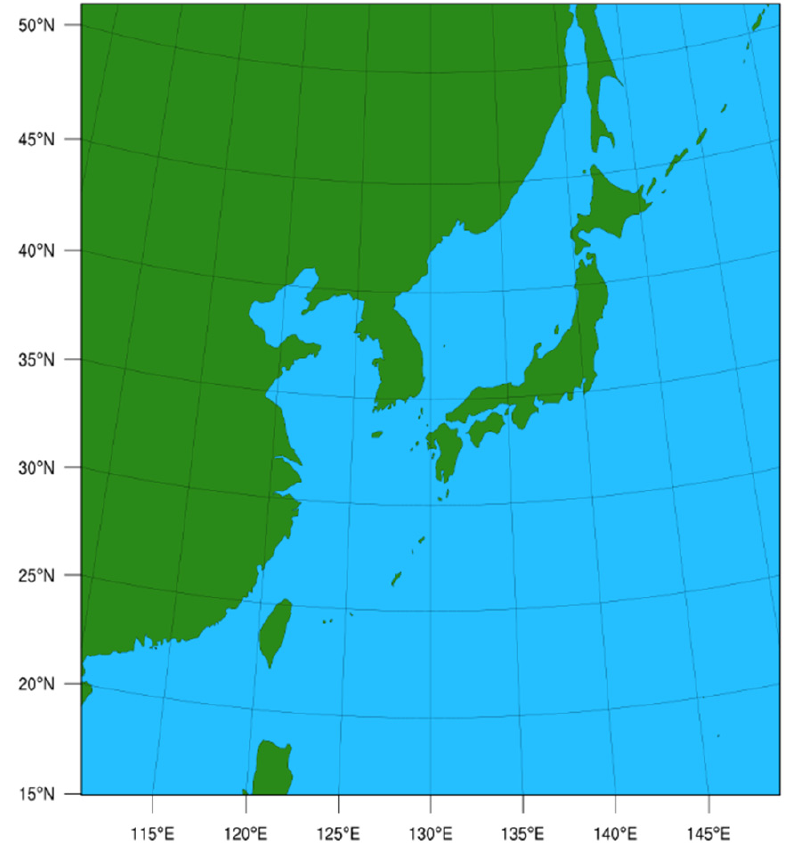
Figure 5. The simulation area of WRF-Northwestern Pacific Ocean (NWP); 2048 × 2048 resolution, dt = 5 s.